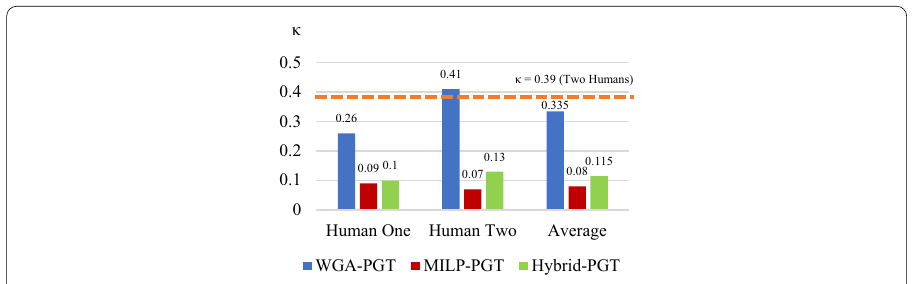
Fig. 3 The κ value of 250 user reviews of the Amazon dataset. The κ value between the two human annotators is 0.39 (orange horizontal